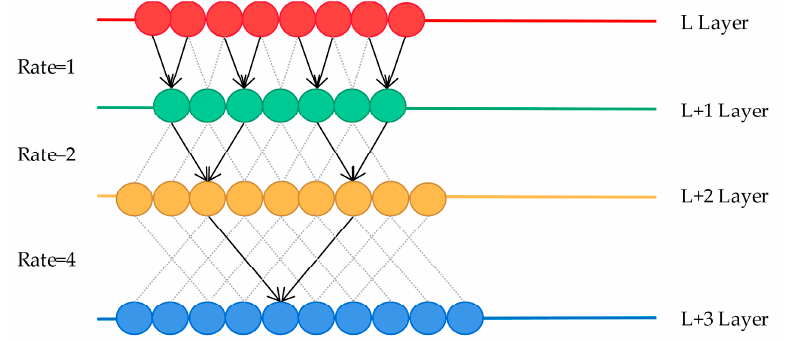
Figure 2. The working principle of dilated convolution.